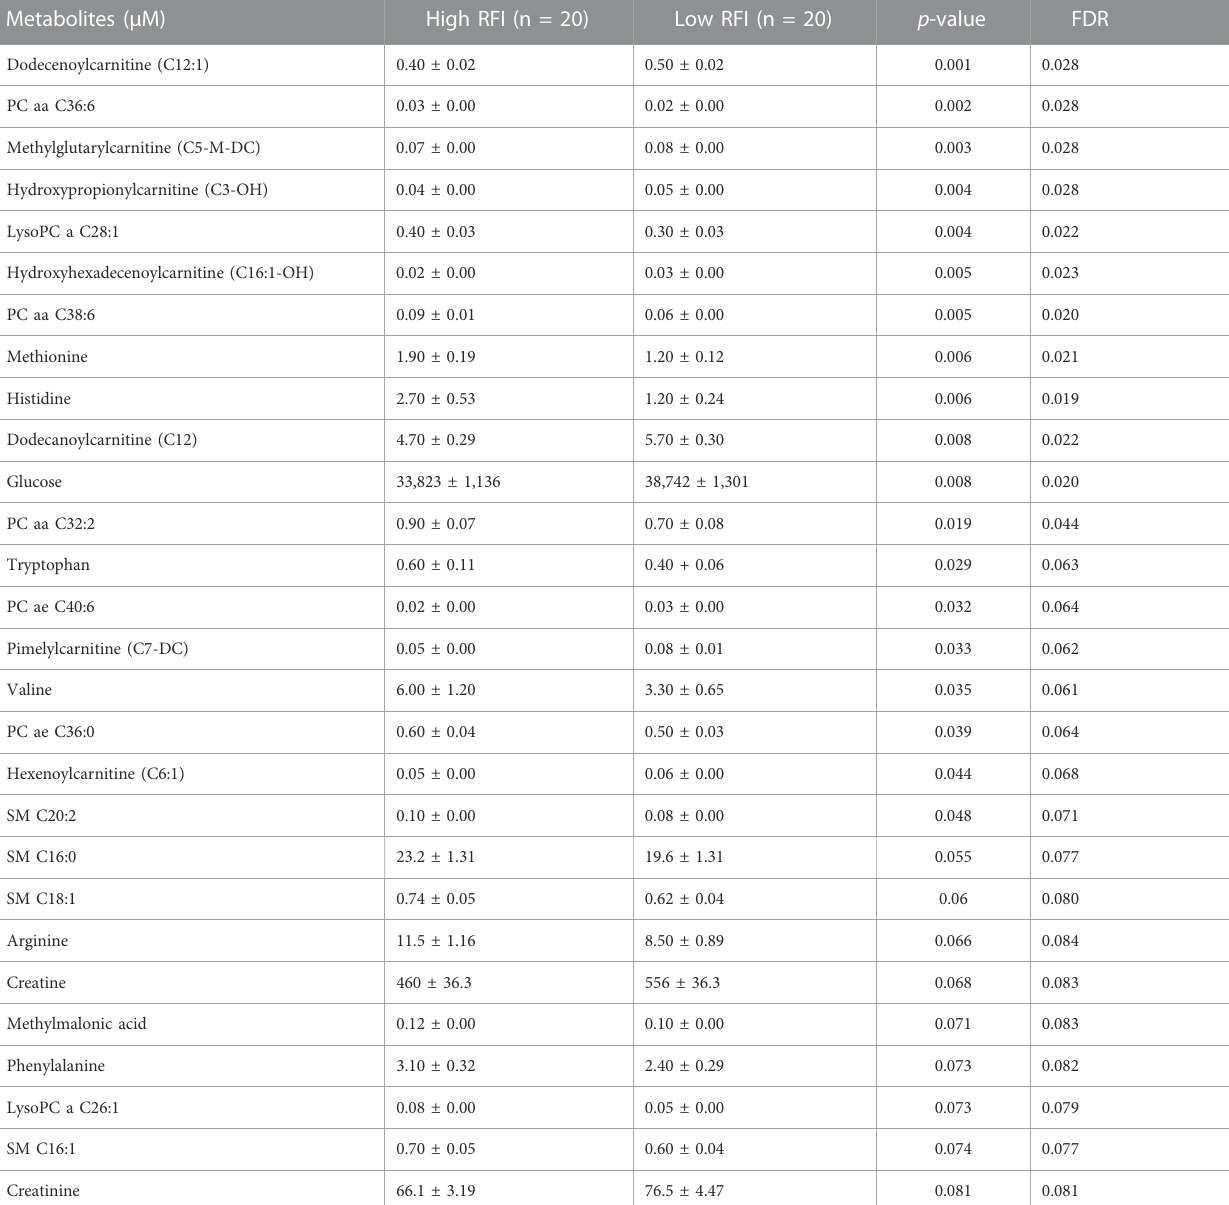
TABLE 3 List of milk metabolites with altered concentrations in the high vs. low RFI comparisons at mid lactation stage. The metabolite concentrations were described in least square means (LSM) and corresponding standard error of mean (SEM) in each group with p -values and false discovery rate (FDR). Metabolites (µM) High RFI (n =